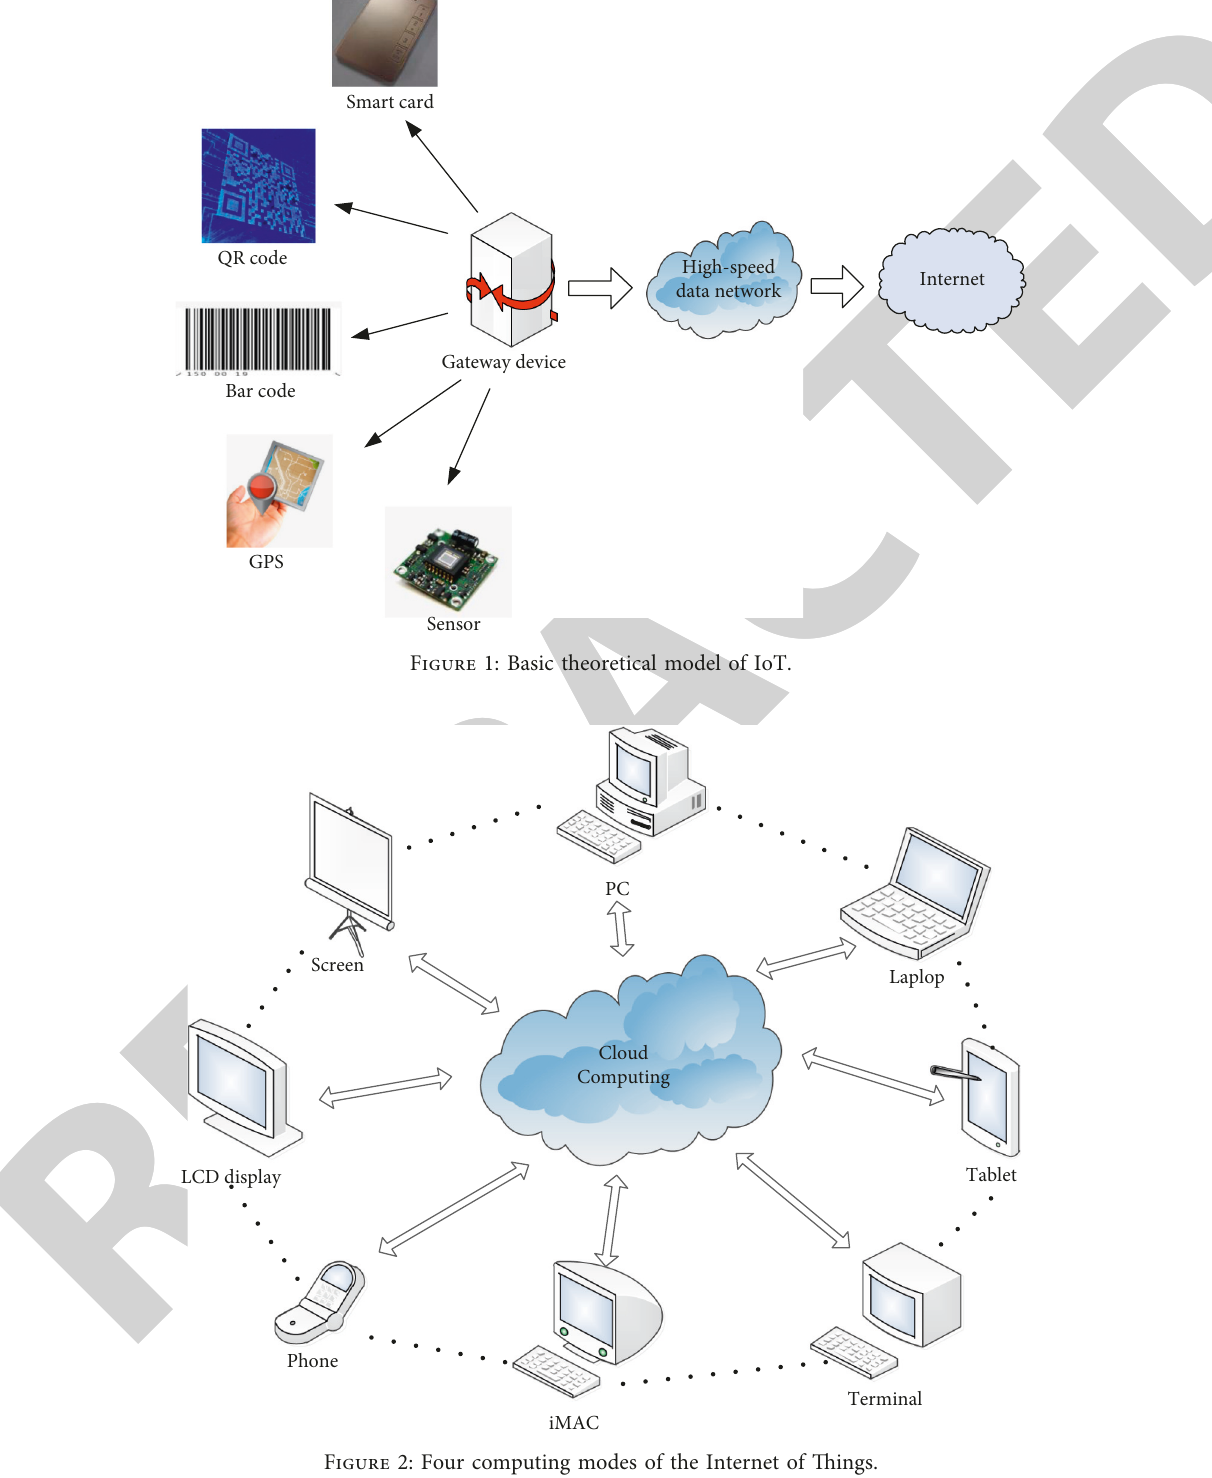
Figure 2: Four computing modes of the Internet of